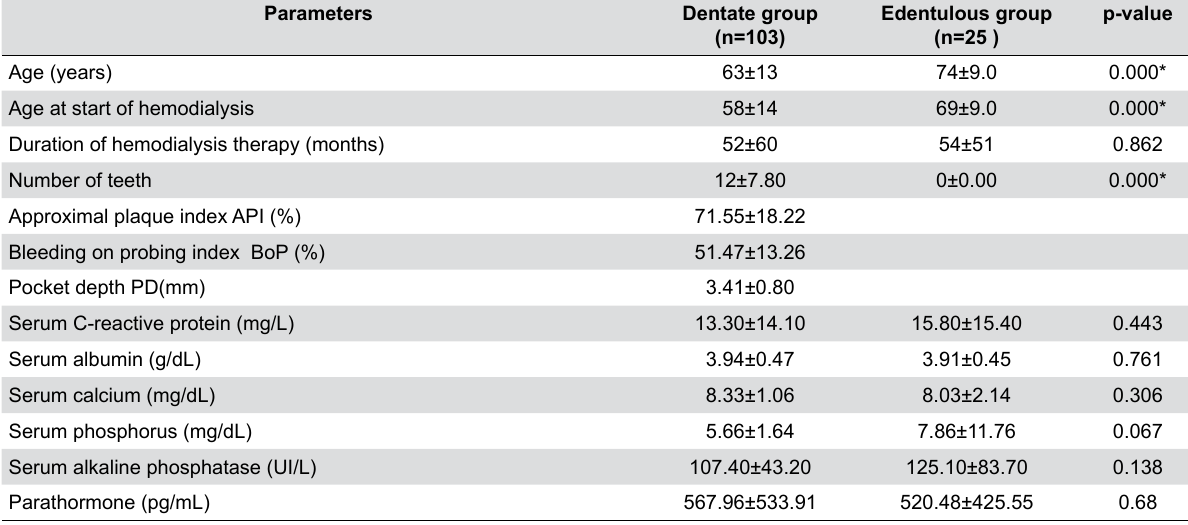
Table 1- Demographic, clinical and laboratory characteristics of hemodialysis patients; quantitative parameters